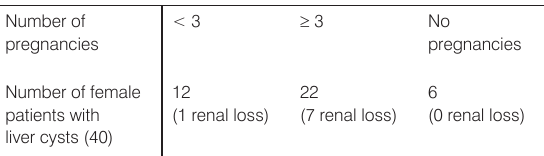
Table 3. Loss of function or renal death in female patients with liver